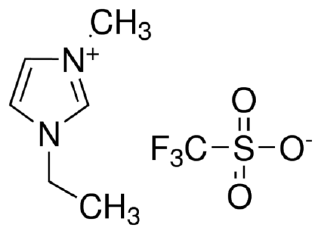
Figure 1. Scheme of the cation and anion composing the investigated ionic liquid.